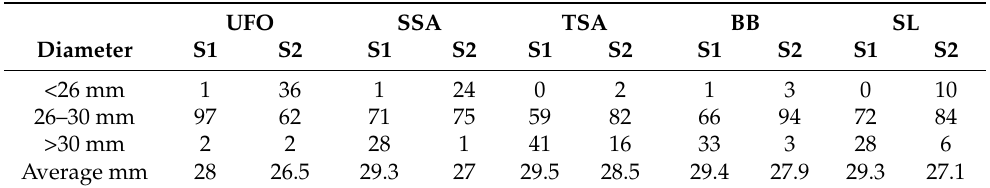
Table 5. Descriptive percentage fruit diameters for first-class sweet cherry cv. ‘Kordia’ fruit